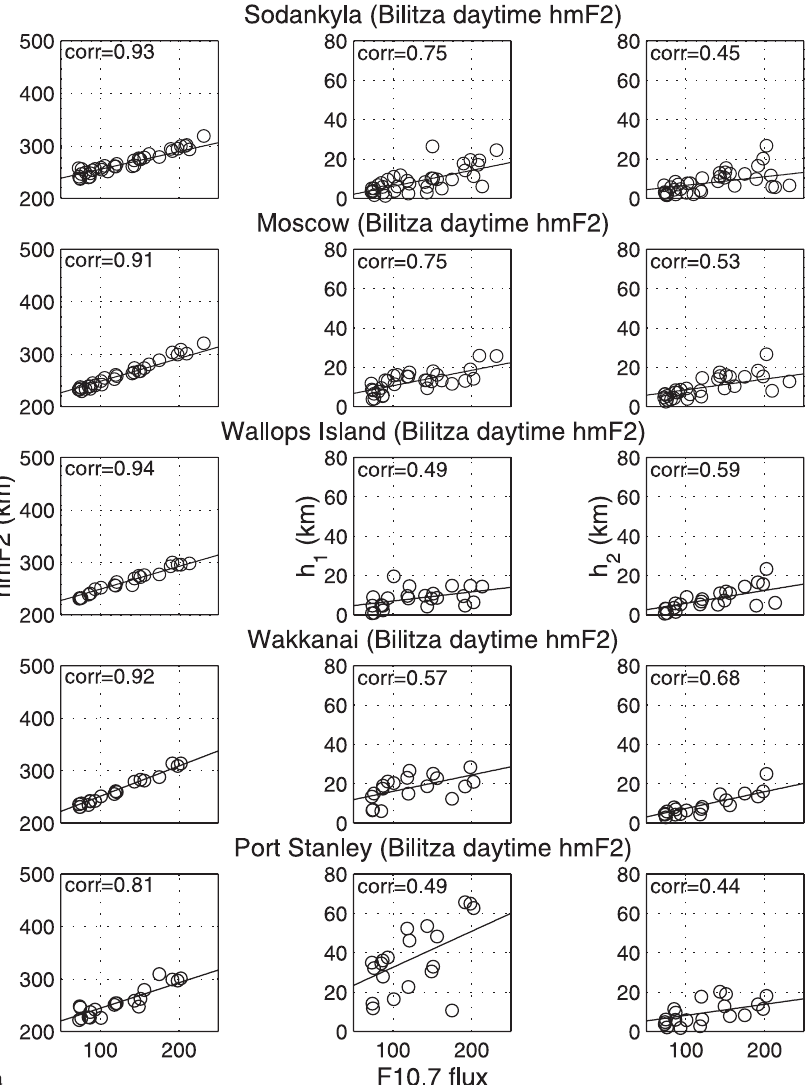
Fig. 5. a Annual means, annual and semi- annual ampitudes of h mF2, derived from ionograms, plotted versus 10.7 cm solar flux at five stations for day (10–14 LT). b Annual means, annual and semiannual ampitudes h mF2, derived from ionograms, plotted versus 10.7 cm solar flux at five stations for night